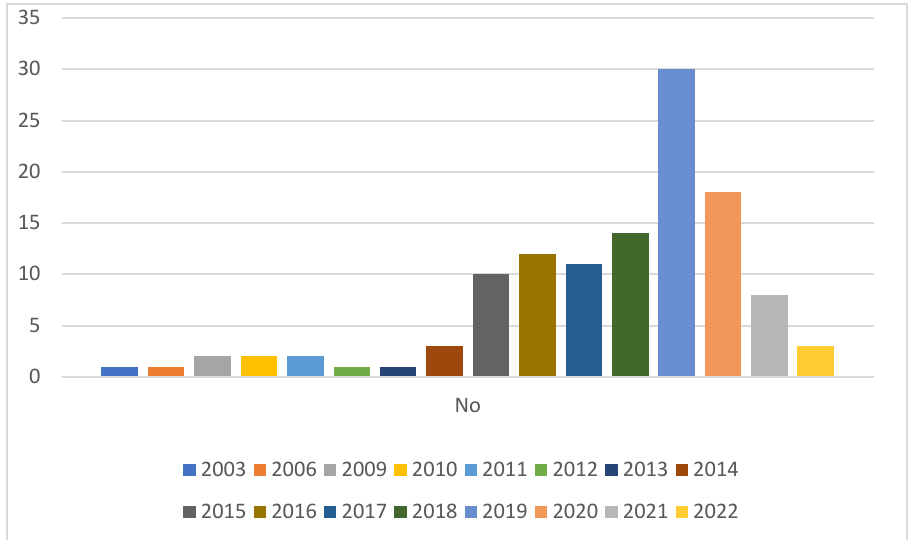
Figure 1. The distribution of the considered papers in the period of time between 2003 and 2022.